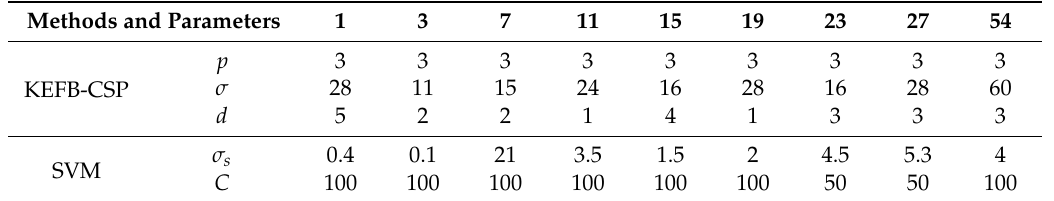
Table 8. Optimum Parameters of KEFB-CSP and SVM for Different Number of Trials n t . Methods and